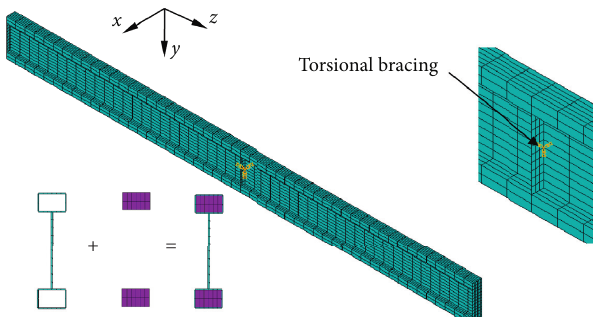
Figure 7: FEM model of the concrete-filled tubular flange girder with torsional bracing.